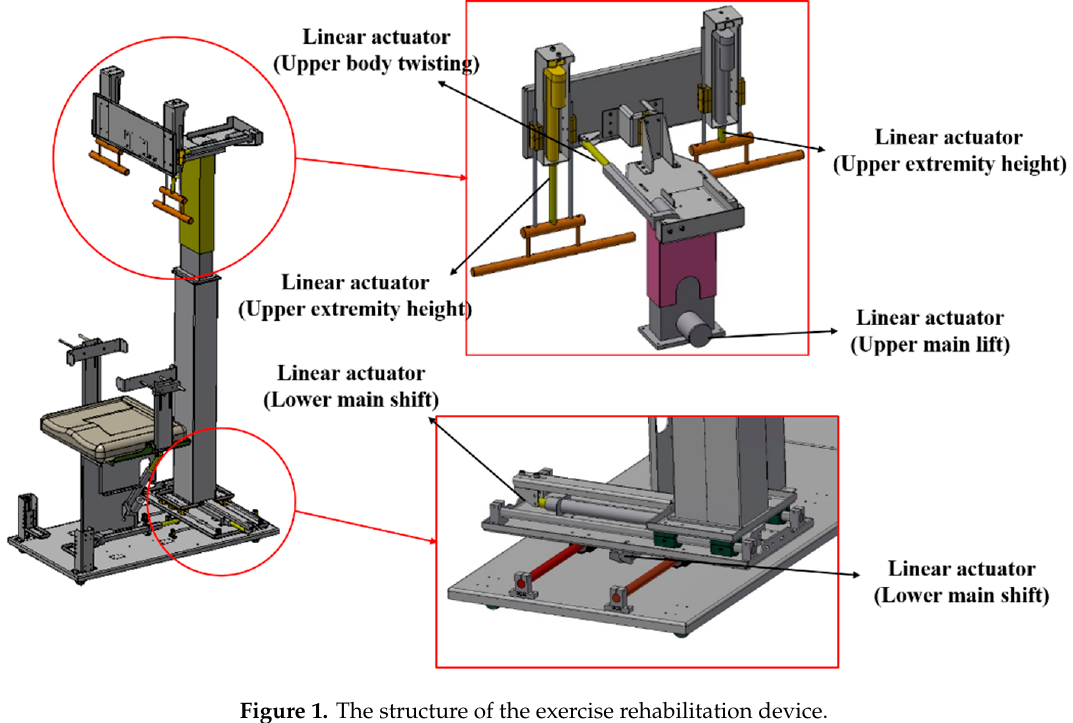
Figure 1. The structure of the exercise rehabilitation device .